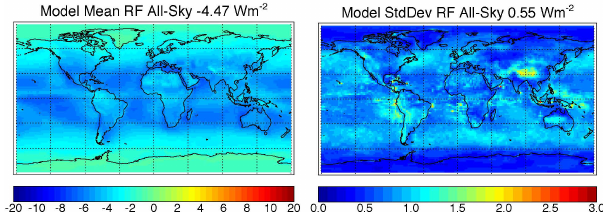
Fig. 6. Annual mean short-wave all-sky top-of-atmosphere radiative forcing (RF) between experiments with AOD=0.2 and AOD=0.0 distributed over the lowest two kilometers, holding SSA=1.0 and ANG=1.0 constant